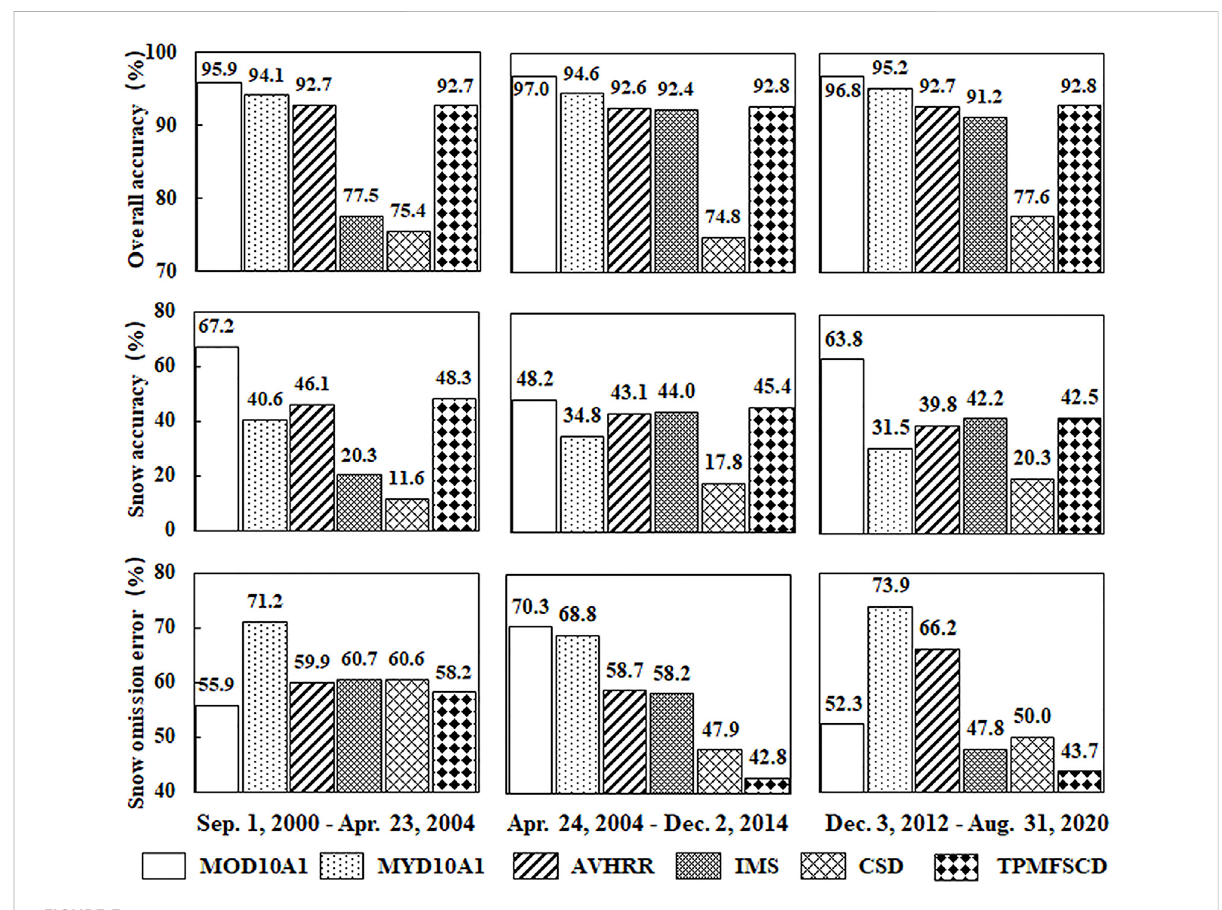
FIGURE 3 Accuracy evaluation of original and multi-source fusion snow cover data. (A) Overall accuracy. (B) Snow accuracy. (C) Snow omission